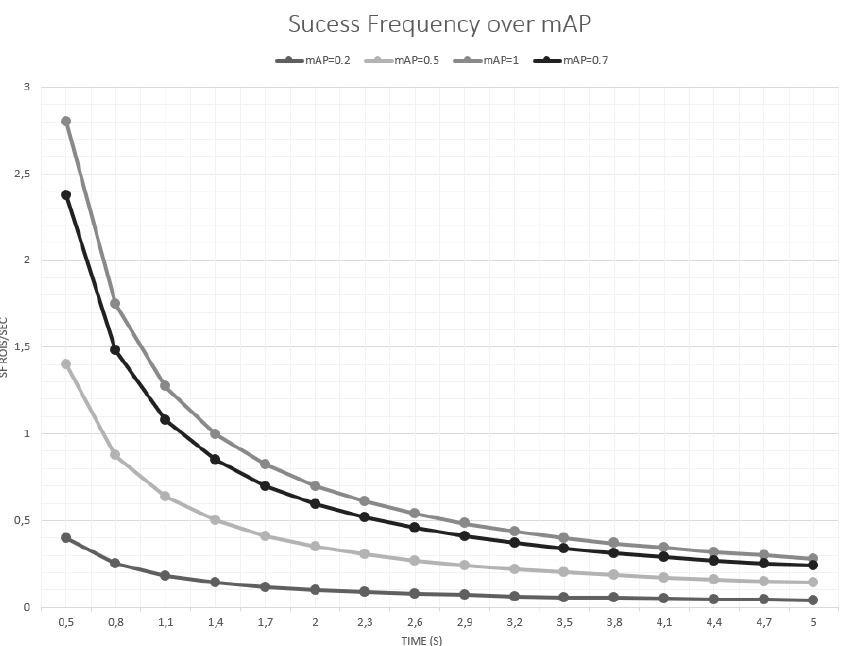
Figure 4. S.F. metric in ROIs/second over the